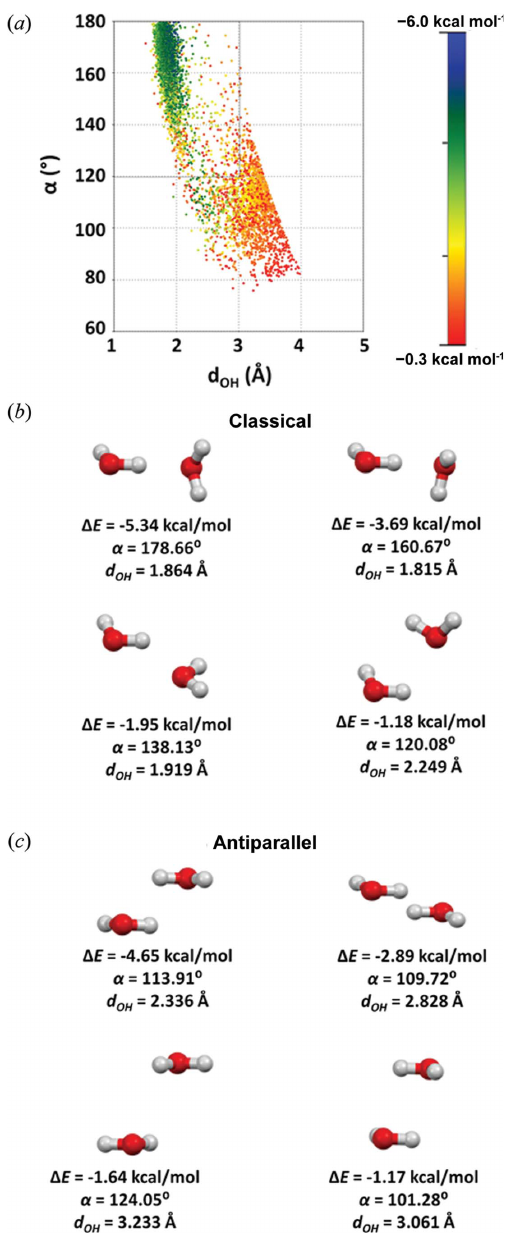
Figure 3 Attractive water–water contacts in the CSD structures. ( a ) Plot of the distance d OH versus angle (cid:2) . The colours correspond to CCSD(T)/CBS interaction energies, as shown in the scale. Graphical representations and CCSD(T)/CBS interaction energies of some examples of water–water interactions from the CSD, with ( b ) classical hydrogen bonds and ( c ) antiparallel interactions.